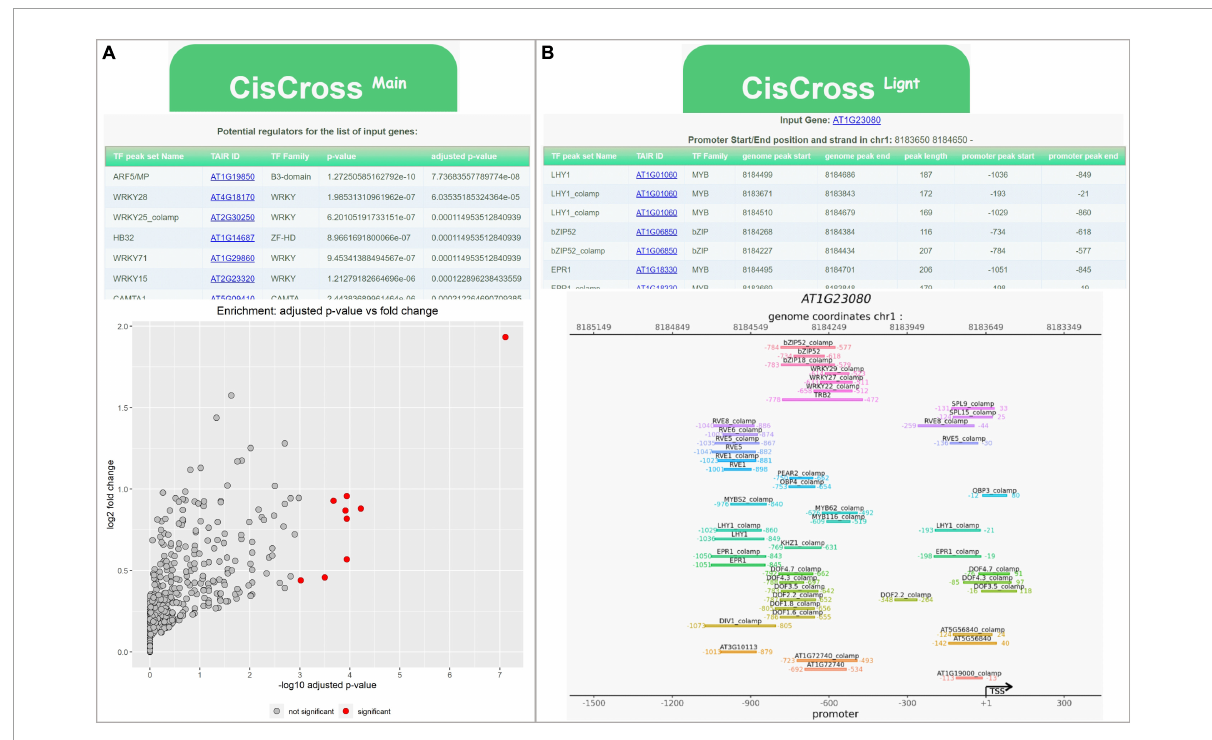
FIGURE4 Examples of the output data for the CisCross web service. (A) CisCross-Main mode for gene list enrichment analysis (for the list of auxin up regulated genes from GSE149410). (B) CisCross-Light mode for the upstream region of PIN7 (AT1G23080)